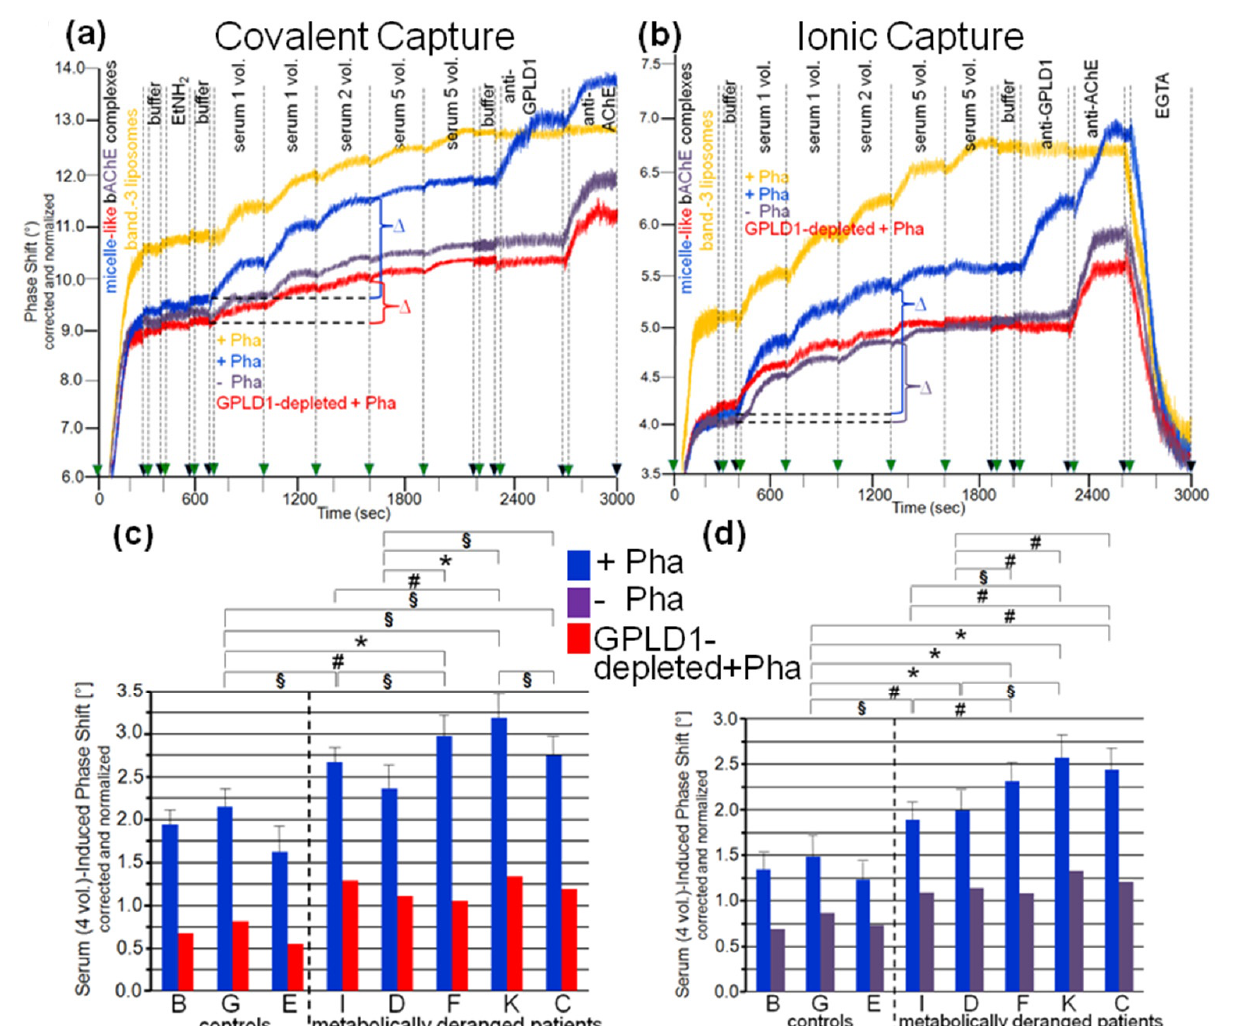
Figure 4. Measurement of the interaction of GPLD1 and other human serum proteins with micelle-like bAChE complexes using covalent ( a , c ) or ionic ( b , d ) capture by the chips. The experiment was performed as described for Figure 3 using pooled serum from the controls ( a , b ) and individual sera from the controls and metabolically deranged patients ( c , d ). ( a , b ) The serum-induced phase shift is calculated as the differences ( ∆ ) measured before (at 700/400 s) and after sequential injection (at 1600/1300 s) of four 100- µ L portions of serum (which guaranteed nonsaturation of the chips for GPI-APs). ( c , d ) The serum-induced phase shift of the individual samples determined in the presence (quadruplicate measurements, blue bars, means ± SD) ( c , d ) and absence (single measurement, purple bars) of Pha ( d ) or upon depletion of GPLD1 by immune adsorption in the presence of Pha (single measurement, red bars) ( c ) is given. The comparison between the individual probands is shown for the samples treated with Pha (blue bars) only (* p ≤ 0.01, # p ≤ 0.02, § p ≤ 0.05). Table 2. Characteristics of the human probands. HbA1c levels of controls (B, G, E) and type 1 dia- betic (T1D; C, D, K) and type 2 diabetic (T2D; F, I) patients of various age, gender (F, female; M, male), body weight, and metabolic state are given.